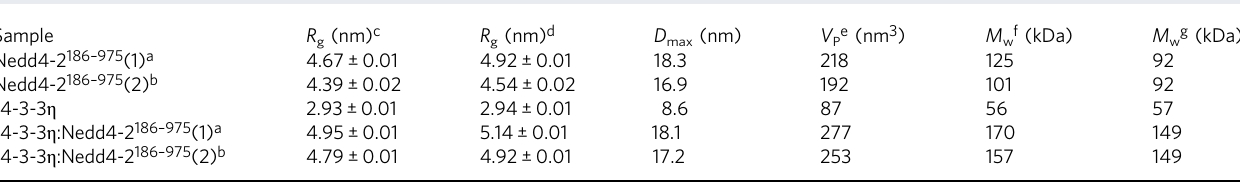
a Based on frames from the top of the elution peak from SEC. b Based on frames from the right side of the elution peak from SEC. c Calculated using the Guinier approximation 82 . d Calculated using GNOM 73 .